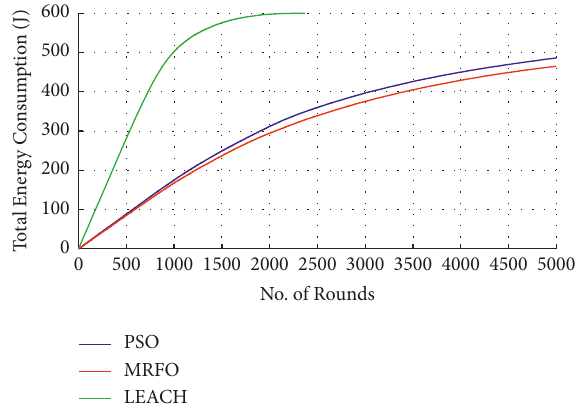
Figure 10: Total energy consumption for 300-node network, 30 CHs when the BS is at the corner of ROI.